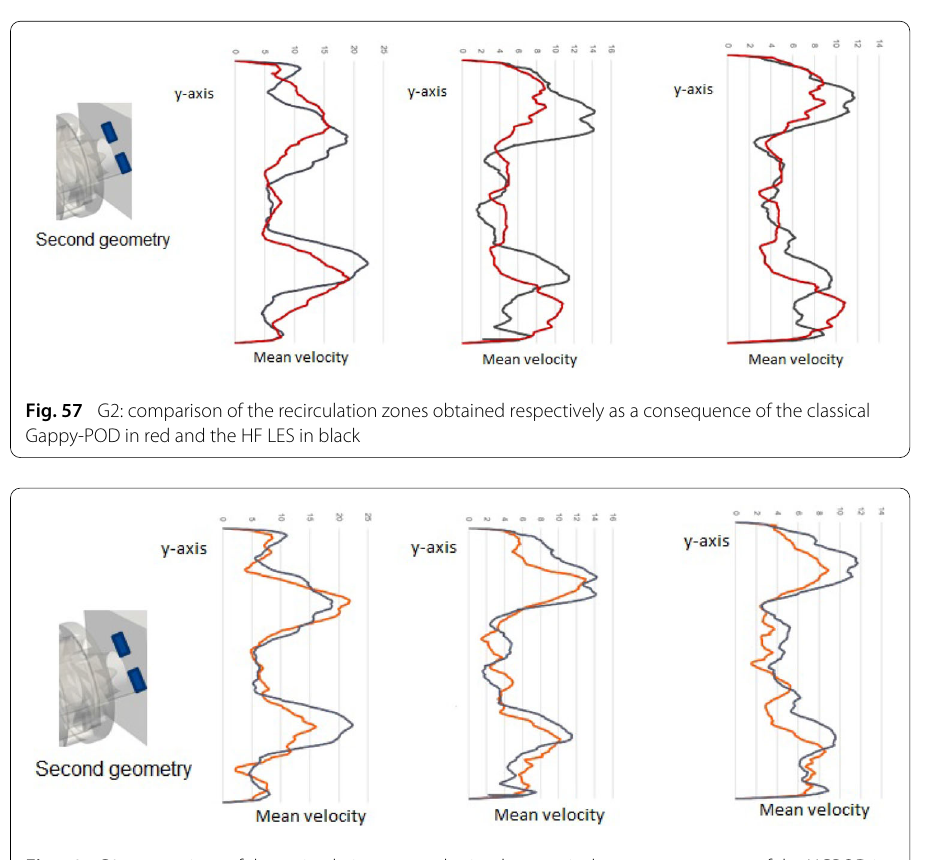
Fig. 58 G2: comparison of the recirculation zones obtained respectively as a consequence of the UGPOD in orange and the HF LES in black